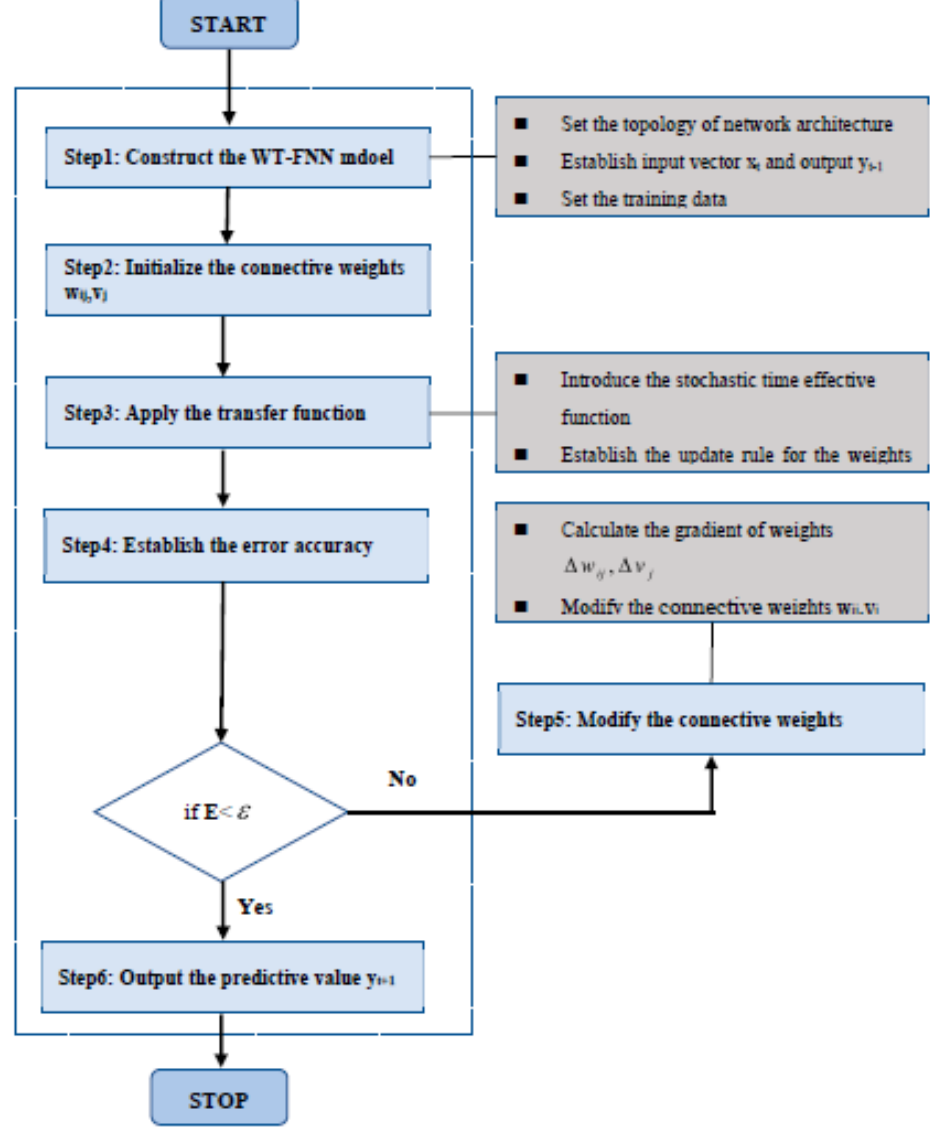
Figure 2. Training algorithm procedures of the WT-FNN.